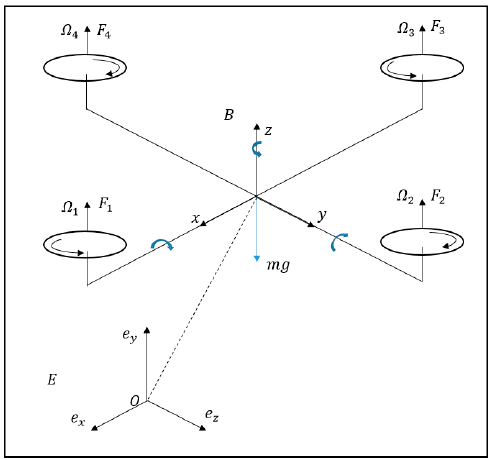
Figure 1. Quadcopter configuration.